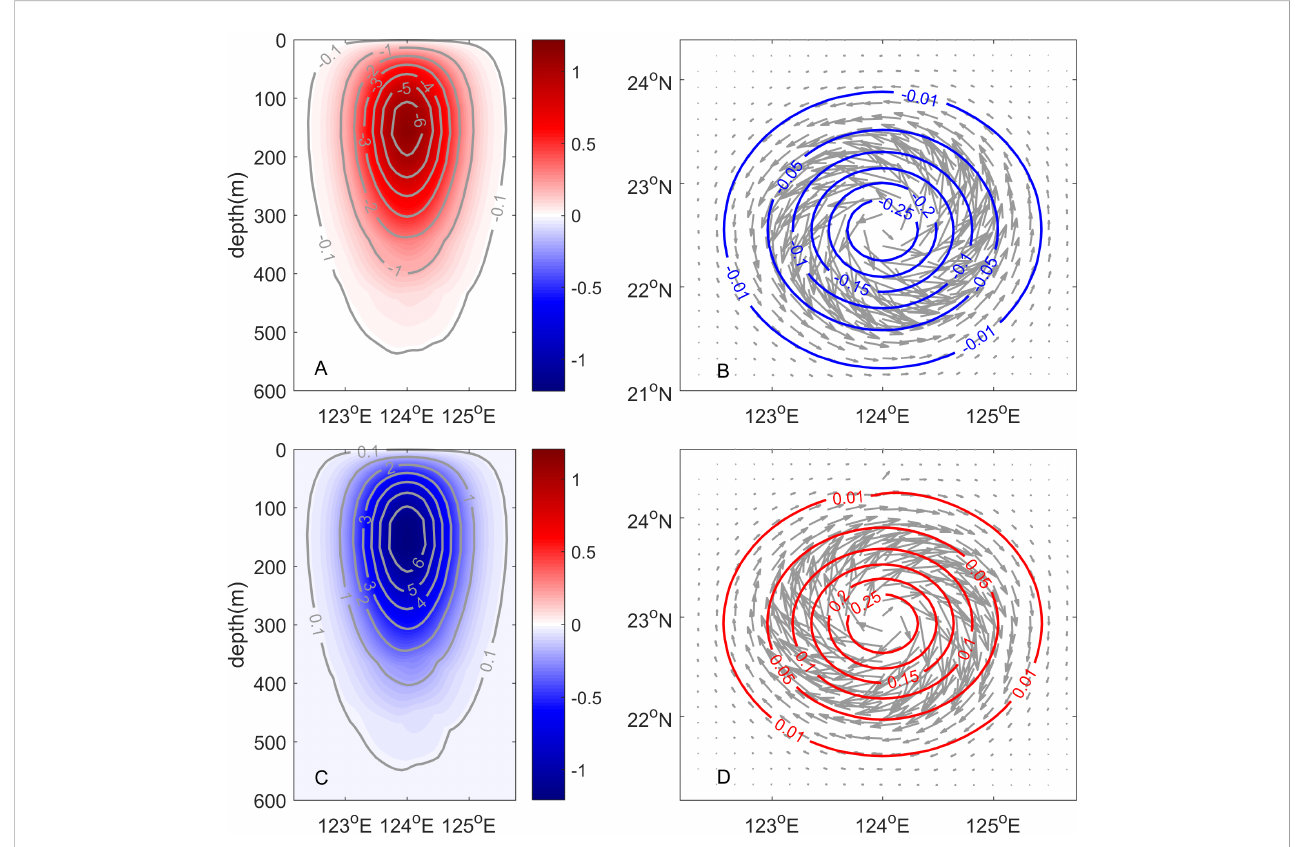
FIGURE 2 The (A, C) temperature (°C) and density (kg/m 3 ) pro fi les, (B, D) sea surface height (m) and surface current of constructed Gaussian-type (upper panel) cyclonic and (lower panel) anticyclonic